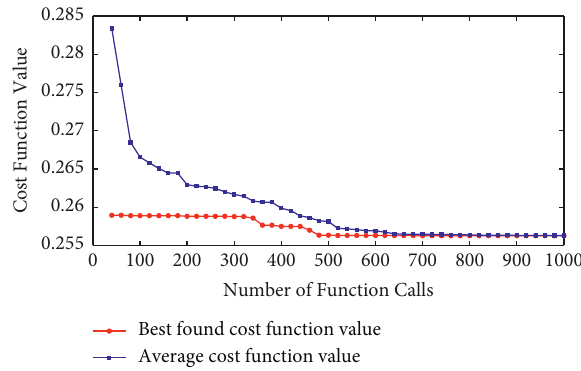
Figure 8: The ODFP optimization